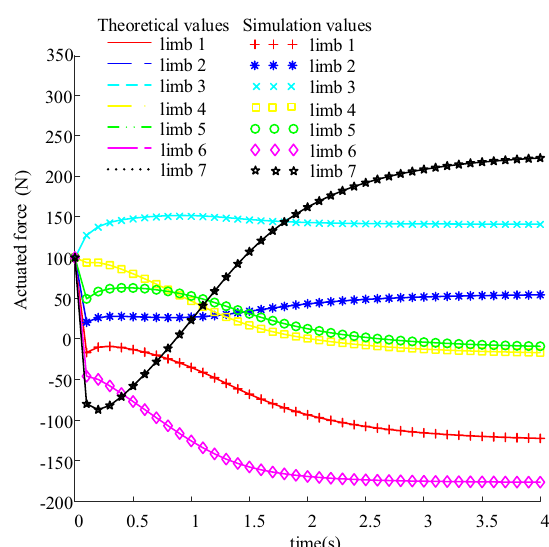
Figure 9 Comparison between theoretical and simulation values of the actuated